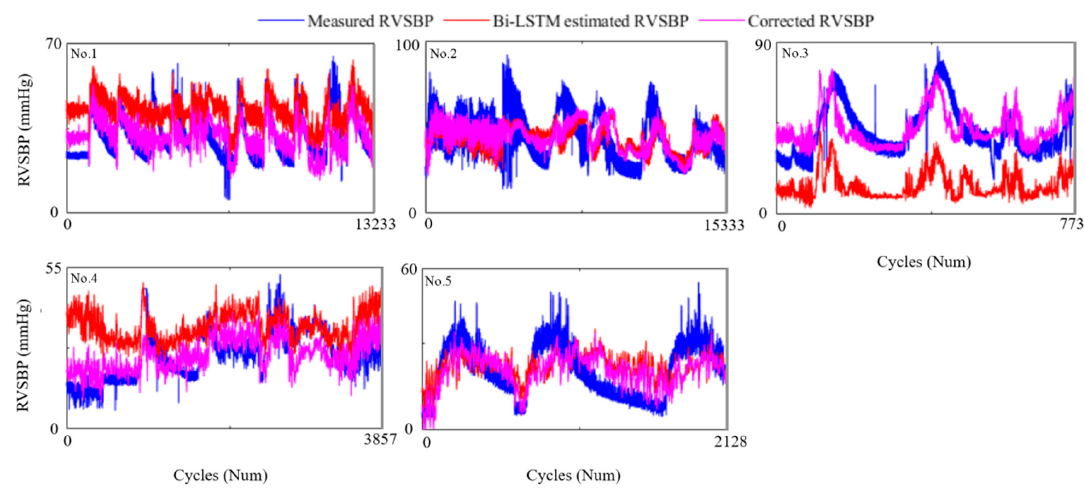
Figure 8. Performance of scheme III.